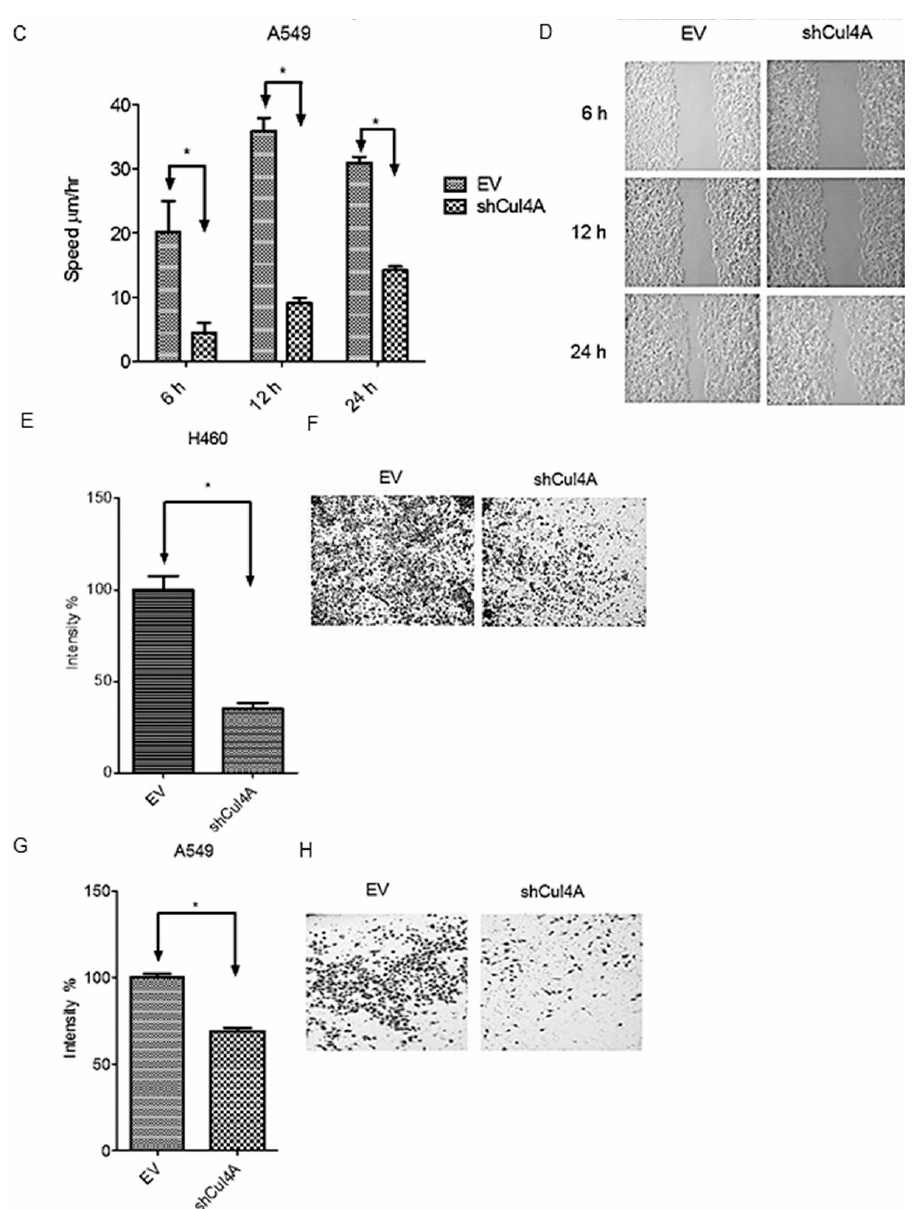
Figure 3. Cul4A knockdown represses metastasis and invasion in lung cancer cells. ( A , B ) Cell migration assay of H460 lung cancer cells. ( C , D ) Cell migration assay of A549 lung cancer cells. Cell migration was observed at the indicated time points. ( E , F ) Cell invasion assay of H460 lung cancer cells. ( G , H ) Cell invasion assay of A549 lung cancer cells. Cell invasion was observed after 48 h. H460 and A549 lung cancer cells were transfected with empty vector (EV) and Cul4A shRNA (shCul4A). Experiments were performed in triplicate. Data points represent the average migration speed or cell intensity ± standard deviation. * denotes p < 0.05. h: hours. Original magnification, 100×. 3.4. Cell Migration and Invasion are Restored by Knockdown of ANXA10 in Cul4A Knockdown Lung Cancer Cells To evaluate the effect of ANXA10 on the cell migration and invasion of lung cancer cells, ANXA10 knockdown assay using ANXA10 siRNA was performed in Cul4A knockdown H460 and